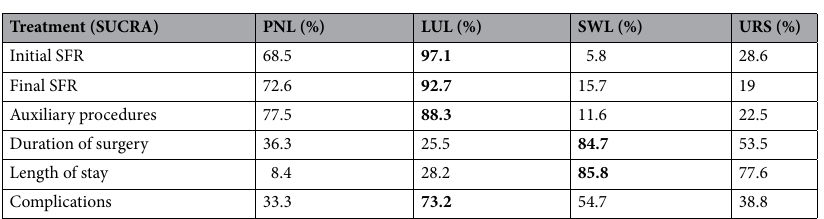
Table 2. Surface under cumulative ranking area (SUCRA) for all the treatment groups. PNL, percutaneous nephrolithotomy; URS, ureterornoscopy; SEL, shockwave lithotripsy; SFR, stone free rate. Bold signifies the highest SUCRA value in that